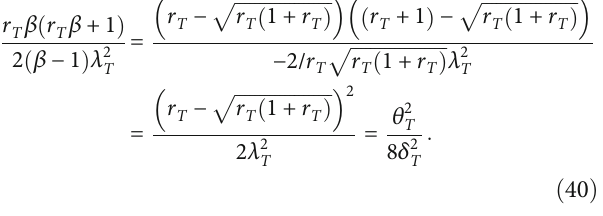
ffiffiffiffiffiffiffiffiffiffiffiffiffiffiffiffiffiffiffiffi r 1 + r T